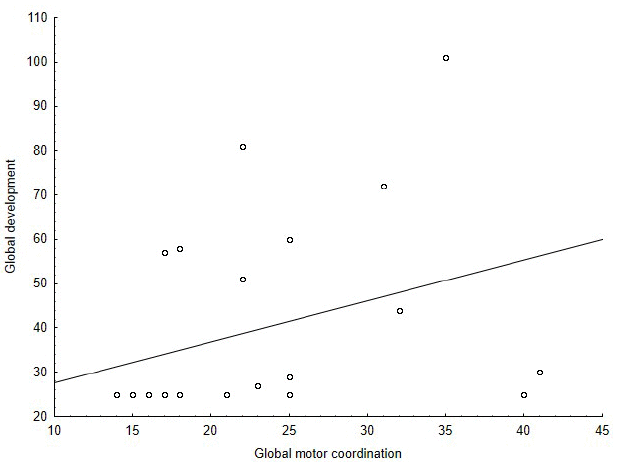
Figure 1. Correlation between global development of the DP-3 and global motor coordination of the M-ABC.